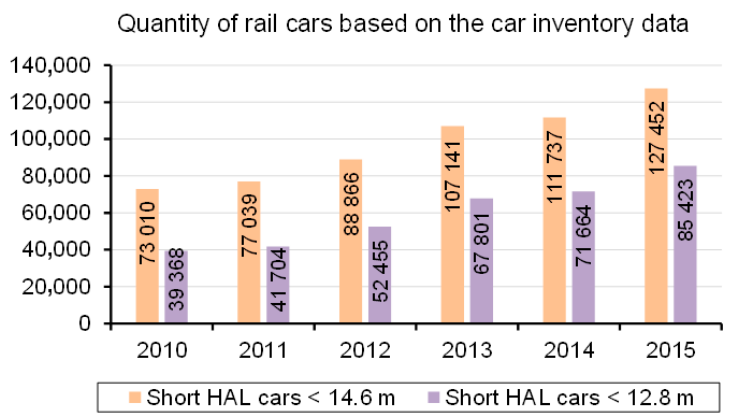
Figure 1. Quantity of short HAL railcars from 2010 to 2015.